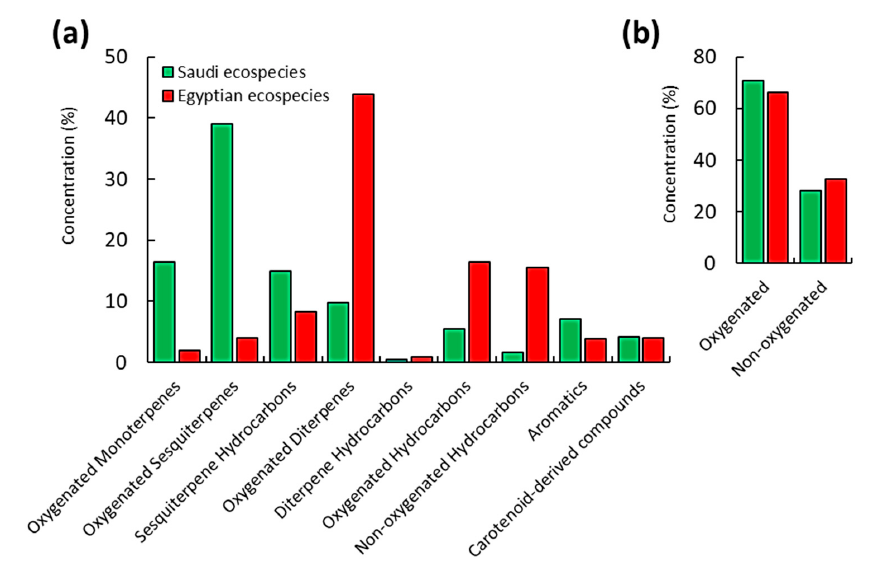
Figure 1. Concentrations of the various classes of the identified compounds. ( a ) the nine identified classes and ( b ) the oxygenated and non-oxygenated components.